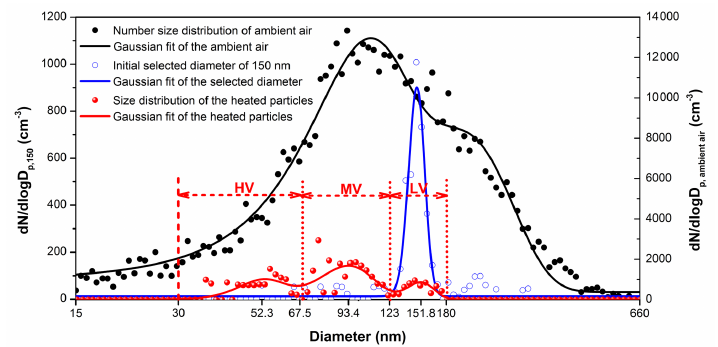
Figure 2. Examples of the particle number size distributions of ambient aerosol (black points), as well as the VTDMA measured room temperature bypass sample ( ∼ 25 ◦ C, blue open circles), and the sample passed through a custom-built heating tube at 300 ◦ C ( D p , 300 ◦ C , red points) for the initial selected diameter of 150nm ( D p ). The corresponding Gaussian fit of the size distributions are shown as black, blue, and red lines. The size distribution obtained after heating was divided into three size ranges according to previously reported empirical cutting diameters. (1) Particles with diameters D p , 300 ◦ C /D p <45% were denoted as “high-volatility” (HV) and were not considered to be BC. (2) Particles with diameters 45%< D p , 300 ◦ C /D p <82% were considered to be internally mixed BC particles (a non-volatile core coated with a volatile shell) and were denoted as “medium-volatility” (MV). (3) Particles with diameters 82%< D p , 300 ◦ C /D p <120% were denoted as “low-volatility” (LV) and were considered to be externally mixed BC.